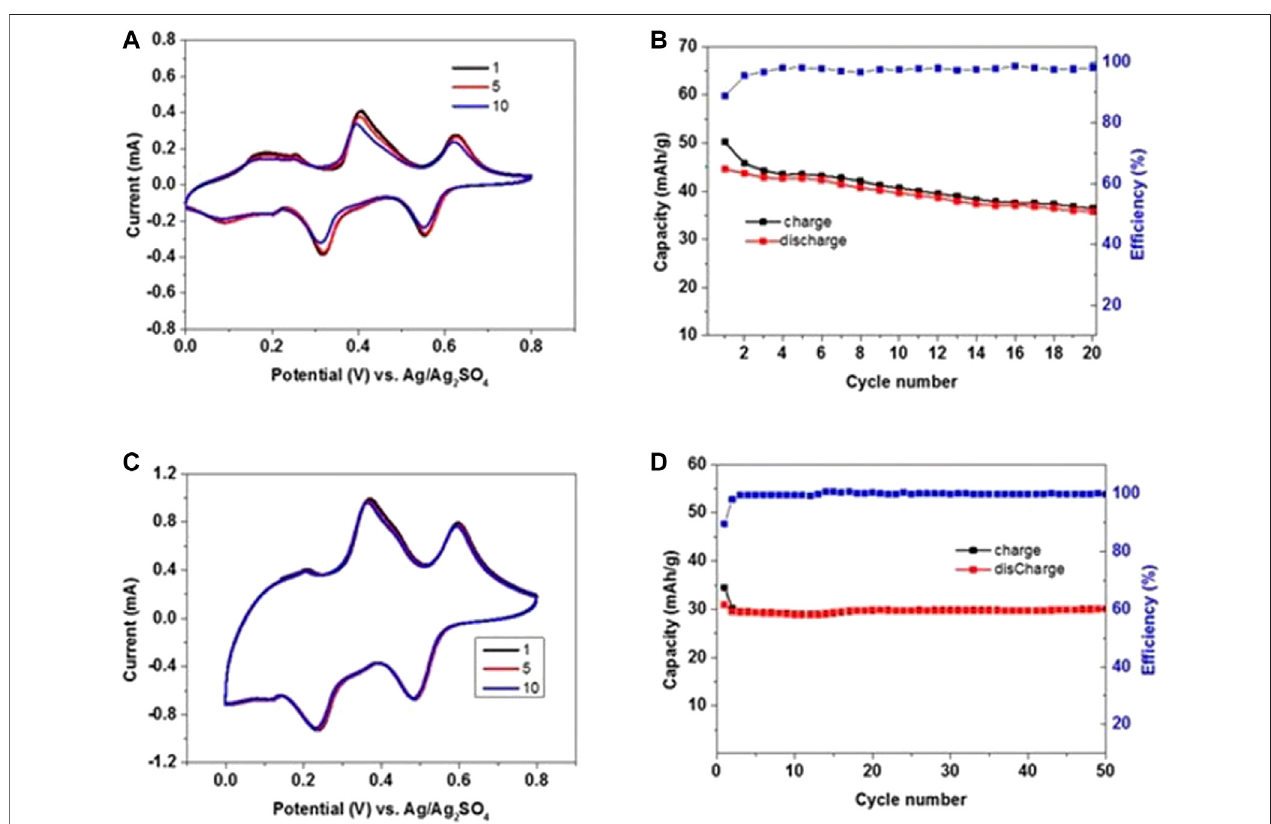
FIGURE 4 | CVs of Na 0.44 MnO 2 WE and AC-rich CE in three-electrode cell con fi guration (electrodes were pressed onto a polymeric web current collector) in 8 m NaClO 4 electrolyte solution and Ag/Ag 2 SO 4 RE (A) measured at a scan rate of 0.1 mV/s up to 20 cycles in the voltage window of 0 – 0.8 V vs. Ag/Ag 2 SO 4 (B) CorrespondingchargeanddischargevaluesinmAh/gduringanodicandcathodicscan,respectively. (C) Thescanrateisincreasedto0.5 mV/safter20cycleswithinthe same voltage range. (D) Charge and discharge values up to 50 cycles at 0.5